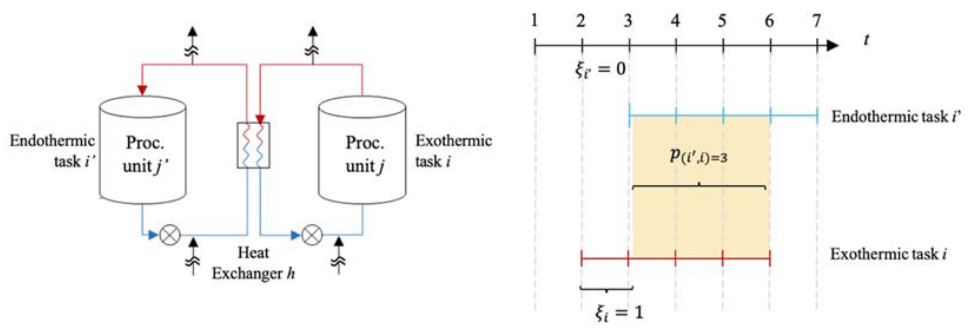
Figure 1. Direct heat integration representation.